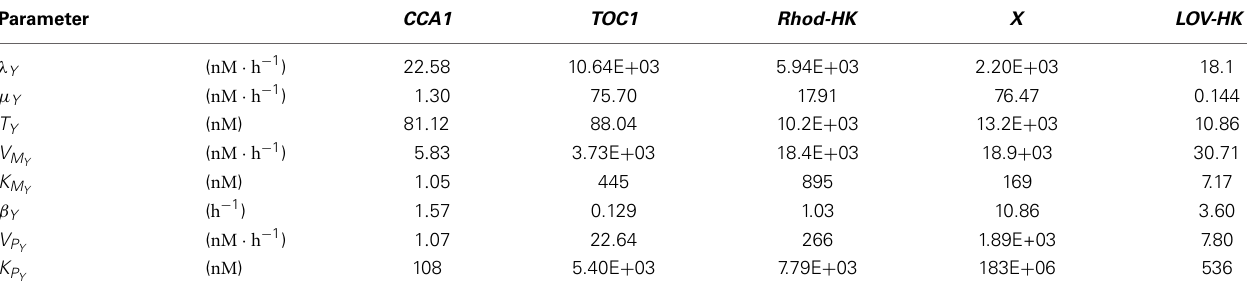
Table 1 | Best-fitting parameter set for the transcriptional-translation network described by Model (1). Parameter